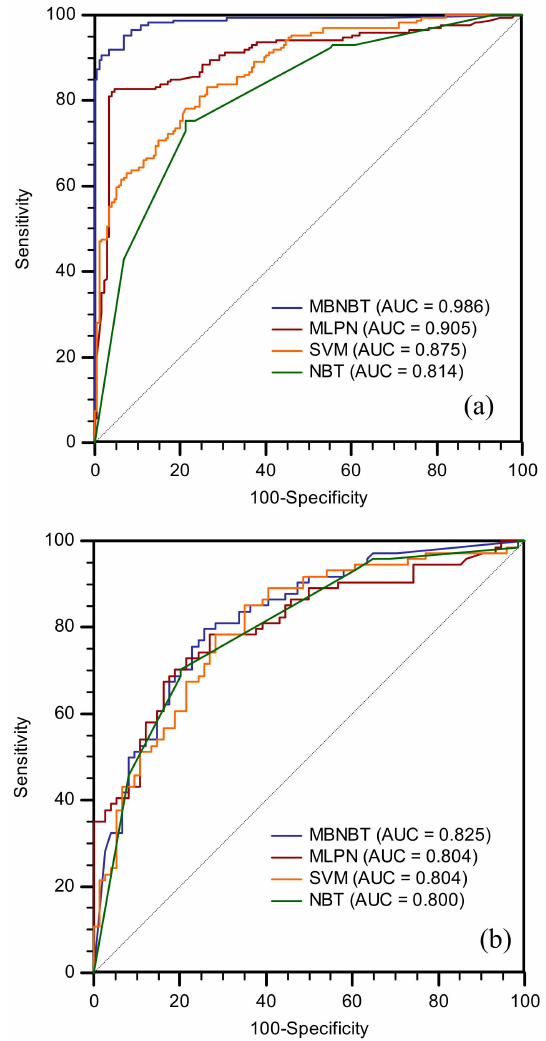
Figure 11. The ROC curve of the di ff erent models using the training dataset ( a ) and validating dataset ( b